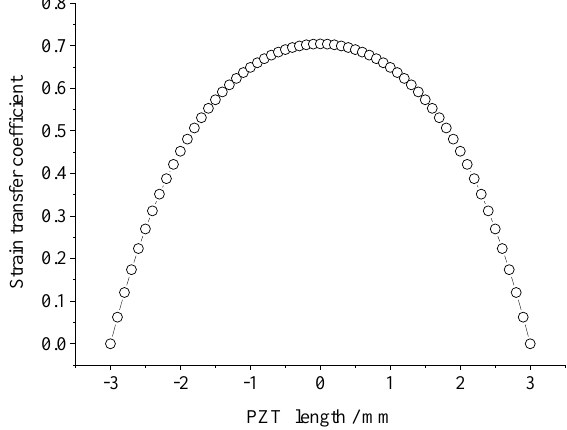
Figure 3. The distribution of strain transfer coefficient of PZT calculated by the theoretical model.